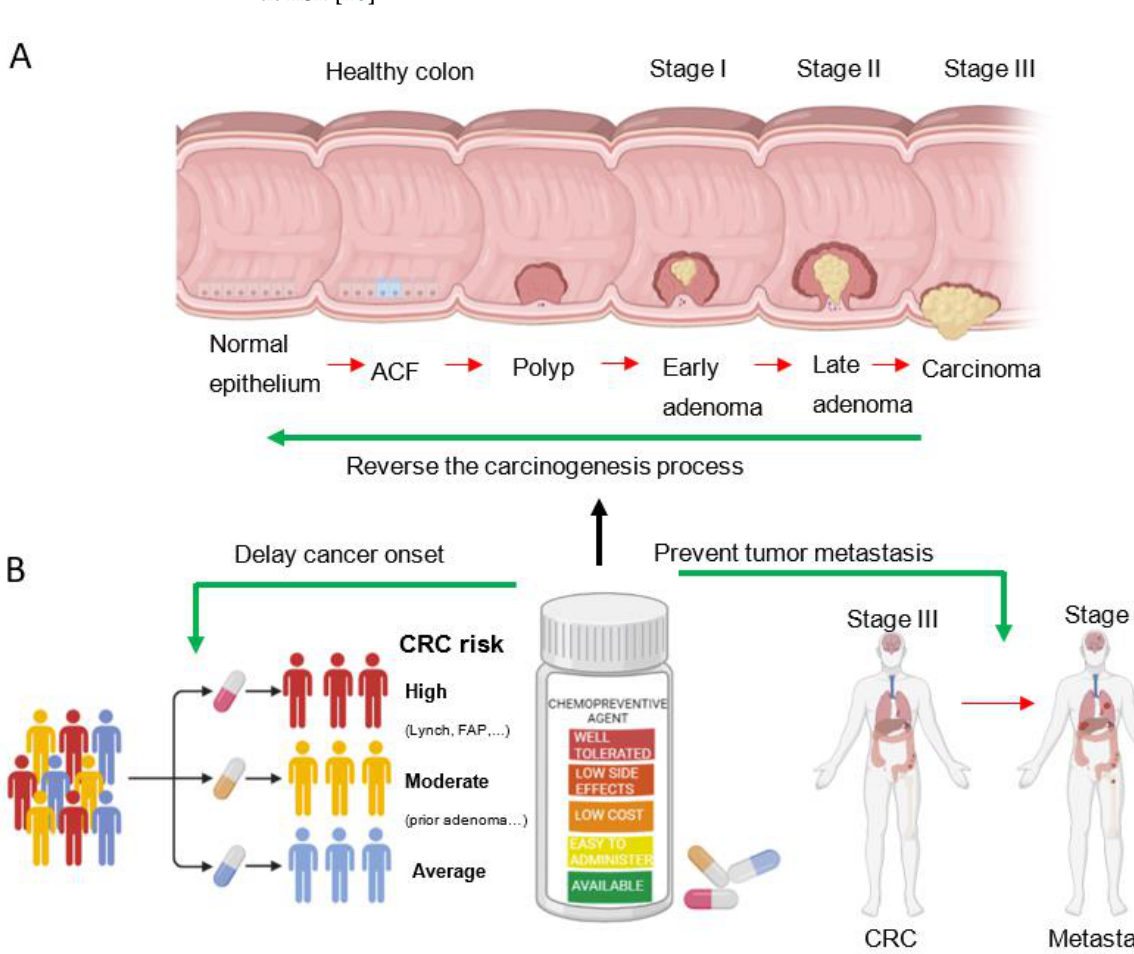
Figure 1. CRC tumorigenesis and chemoprevention. ( A ) Schematic representation of the adenoma- carcinoma sequence, which includes the progression steps, such as aberrant crypt foci (ACF) and adenoma lesions, that are used as endpoints in clinical trials to evaluate potential chemopreventive agents. ( B ) Chemopreventive agents are natural and synthetic compounds intended to delay cancer onset, reverse the carcinogenesis process, and prevent tumor recurrence and metastasis. The ideal chemopreventive agent should be well tolerated, safe, easy to administer, and readily available at low cost. Moreover, chemopreventive agents should be tailored to individuals at high (carriers of genetic syndromes predisposing to CRC, such as Lynch syndrome, all different types of FAP syndrome, MUTYH-associated polyposis, Peutz-Jeghers syndrome, juvenile polyposis syndrome, Cowden syndrome, and hamartoma tumor syndrome, patients with diabetes mellitus), moderate (subjects with a prior diagnosis of colonic adenoma or a family history of CRC), or average (general population, with particular concern for non-Hispanic Black men and individuals with an unhealthy diet) risk of developing CRC ( B ). Created with Biorender.com.